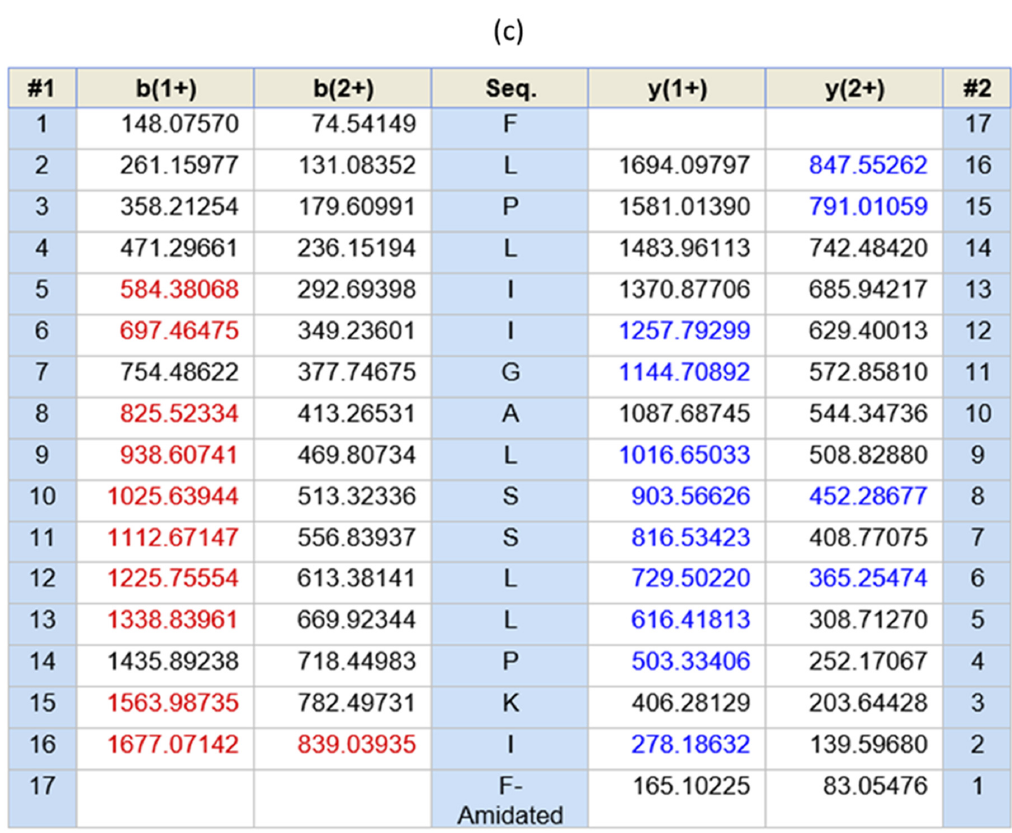
Figure 2. ( a ) The RP-HPLC chromatogram of the skin secretion of Pelophylax kl. esculentus . The peak of temporin-PKE is indicated by an arrow. ( b ) The annotated LCQ tandem mass (MS/MS) fragmentation spectrum of temporin-PKE. Prominent ions in are labeled with the observed m/z value and ion series designation. b and y denote the N- and C-terminal fragments of the peptide produced by breakage at the peptide bond in LCQ, respectively. The number represents the residue number from either the N- or C- terminus. ( c ) Electrospray ion-trap MS/MS fragmentation data derived from fragment ions in panel ( b ) corresponding in molecular mass to temporin-PKE. Predicted singly- and doubly-charged ions are coloured black. The actual b-ions and y-ions detected by MS/MS fragmentation are indicated in red and blue typeface, respectively.